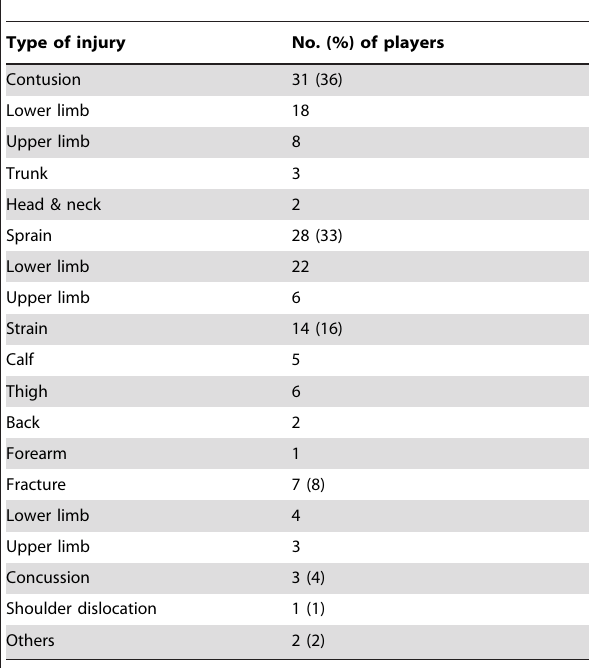
Table 3. Type of injury diagnosed during the 2010 FELDA/ FAM National Futsal